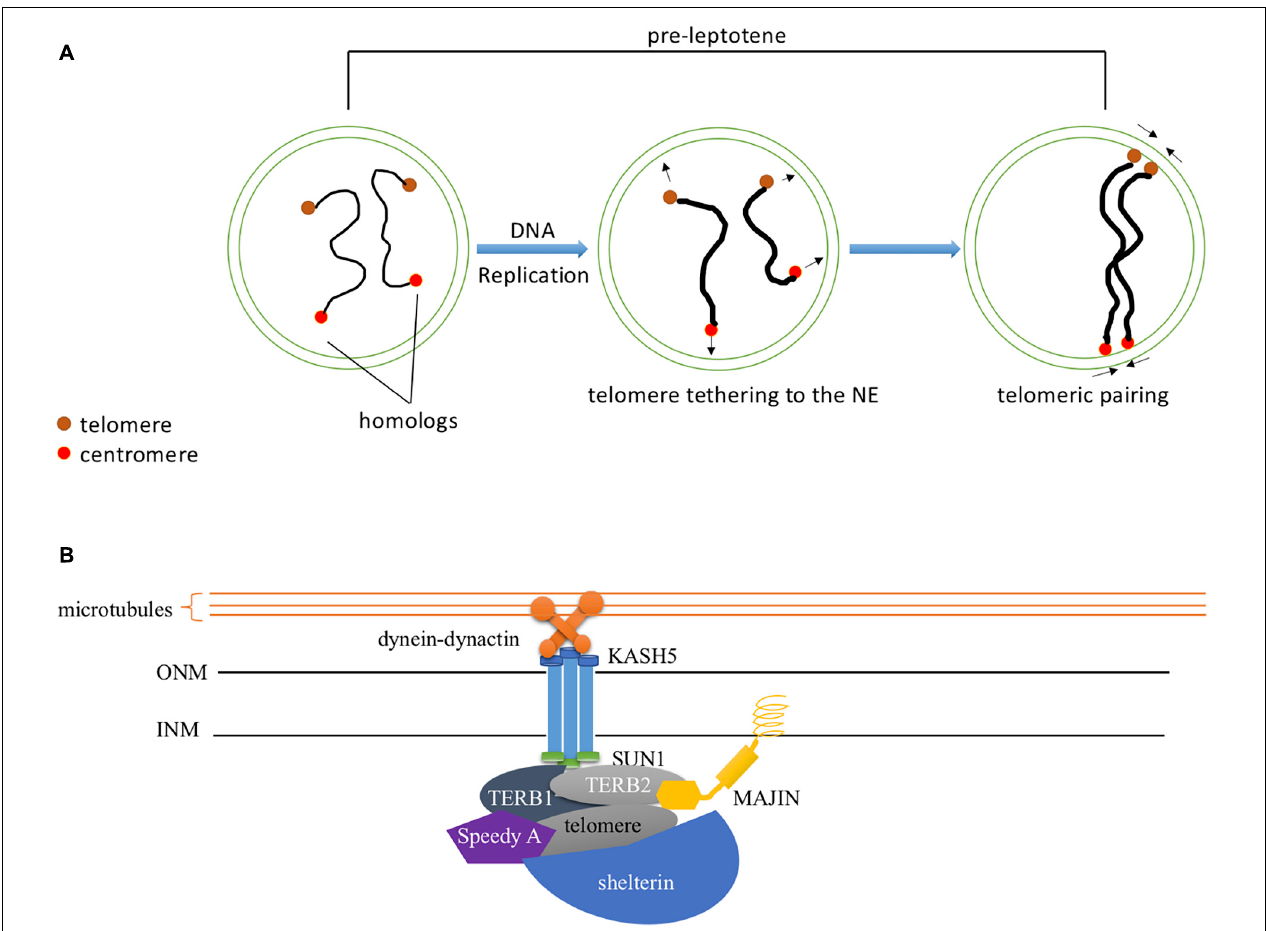
FIGURE 3 | DSB-Independent Homolog Pairing (A) DSB-independent pairing at pre-leptotene. Telomeric homolog pairing occurs at pre-leptotene independent of DSB formation. SPO11, not through its catalytic activity, is required for this process. Interstitial pairing is promoted by telomeric pairing and its frequency decreases upon leptotene entry. (B) Meiotic specific protein regulation of telomere-NE attachment. Speedy A localizes to the telomere and regulates its association to the NE. TERB1/2-MAJIN attaches the telomere-shelterin complex to the nuclear envelope by anchoring MAJIN within the INM. The downstream accumulation of the SUN1-KASH5 complex to the telomere attachment site facilitates chromosome movement by linking it to the dynein-dynactin motors through KASH5.